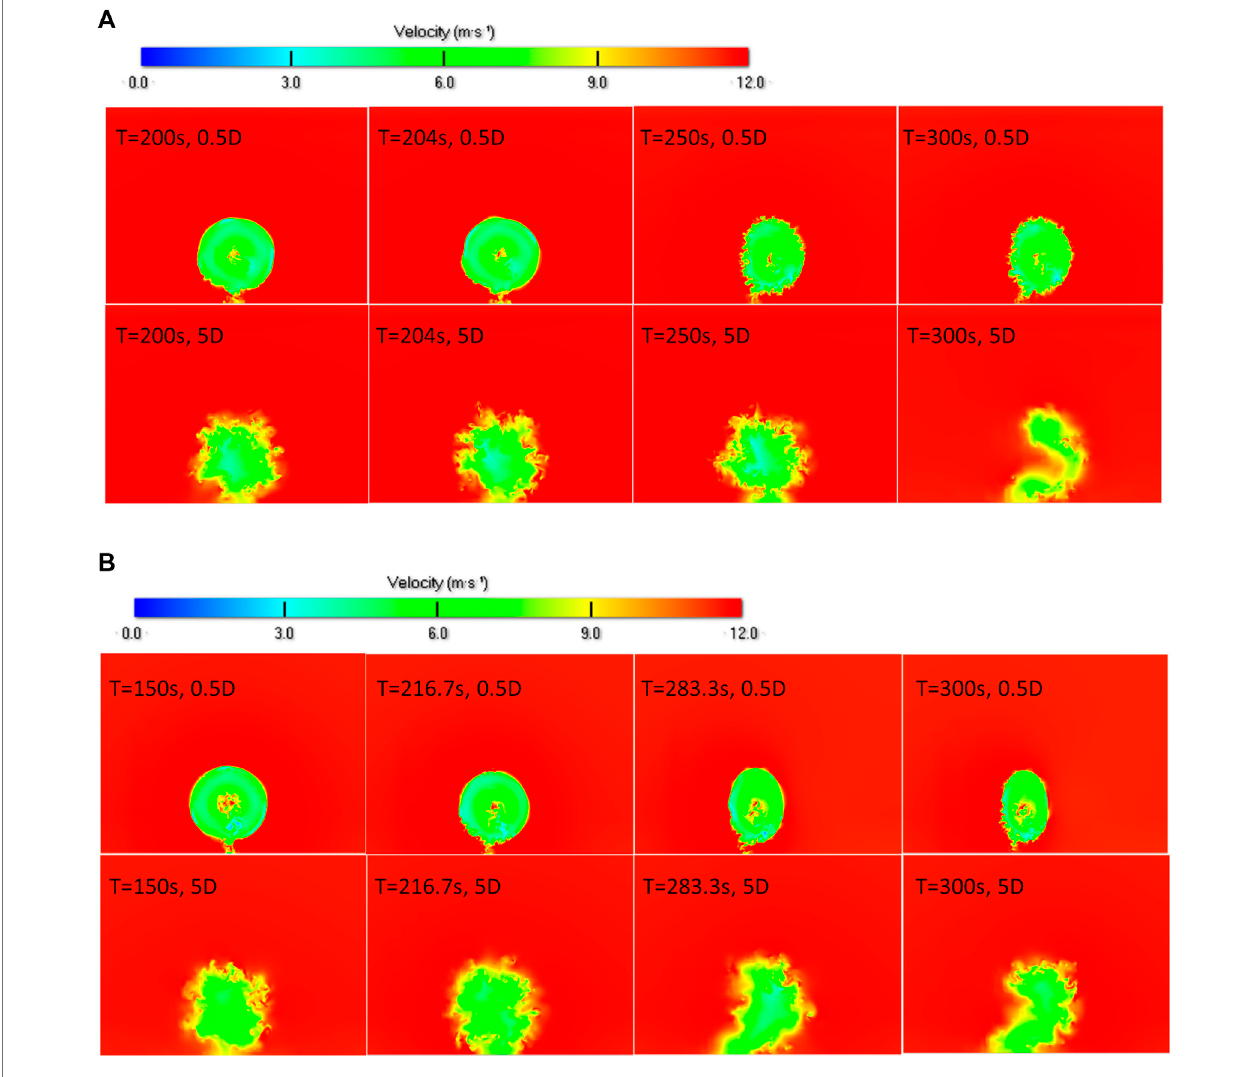
Frontiers in Energy Research |